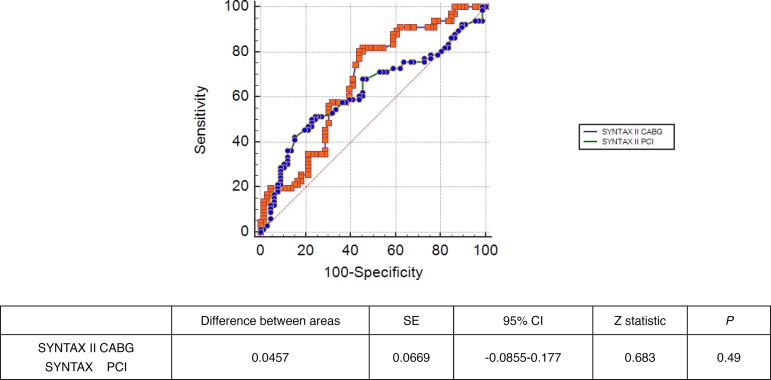
Pairwise comparison of ROC curves of SYNTAX II CABG and PCI for prediction of significant carotid artery stenosis. 95% CI=95% confidence interval; AUC=area under the curve; CABG=coronary artery bypass grafting; PCI=percutaneous coronary intervention; SE=Standard error